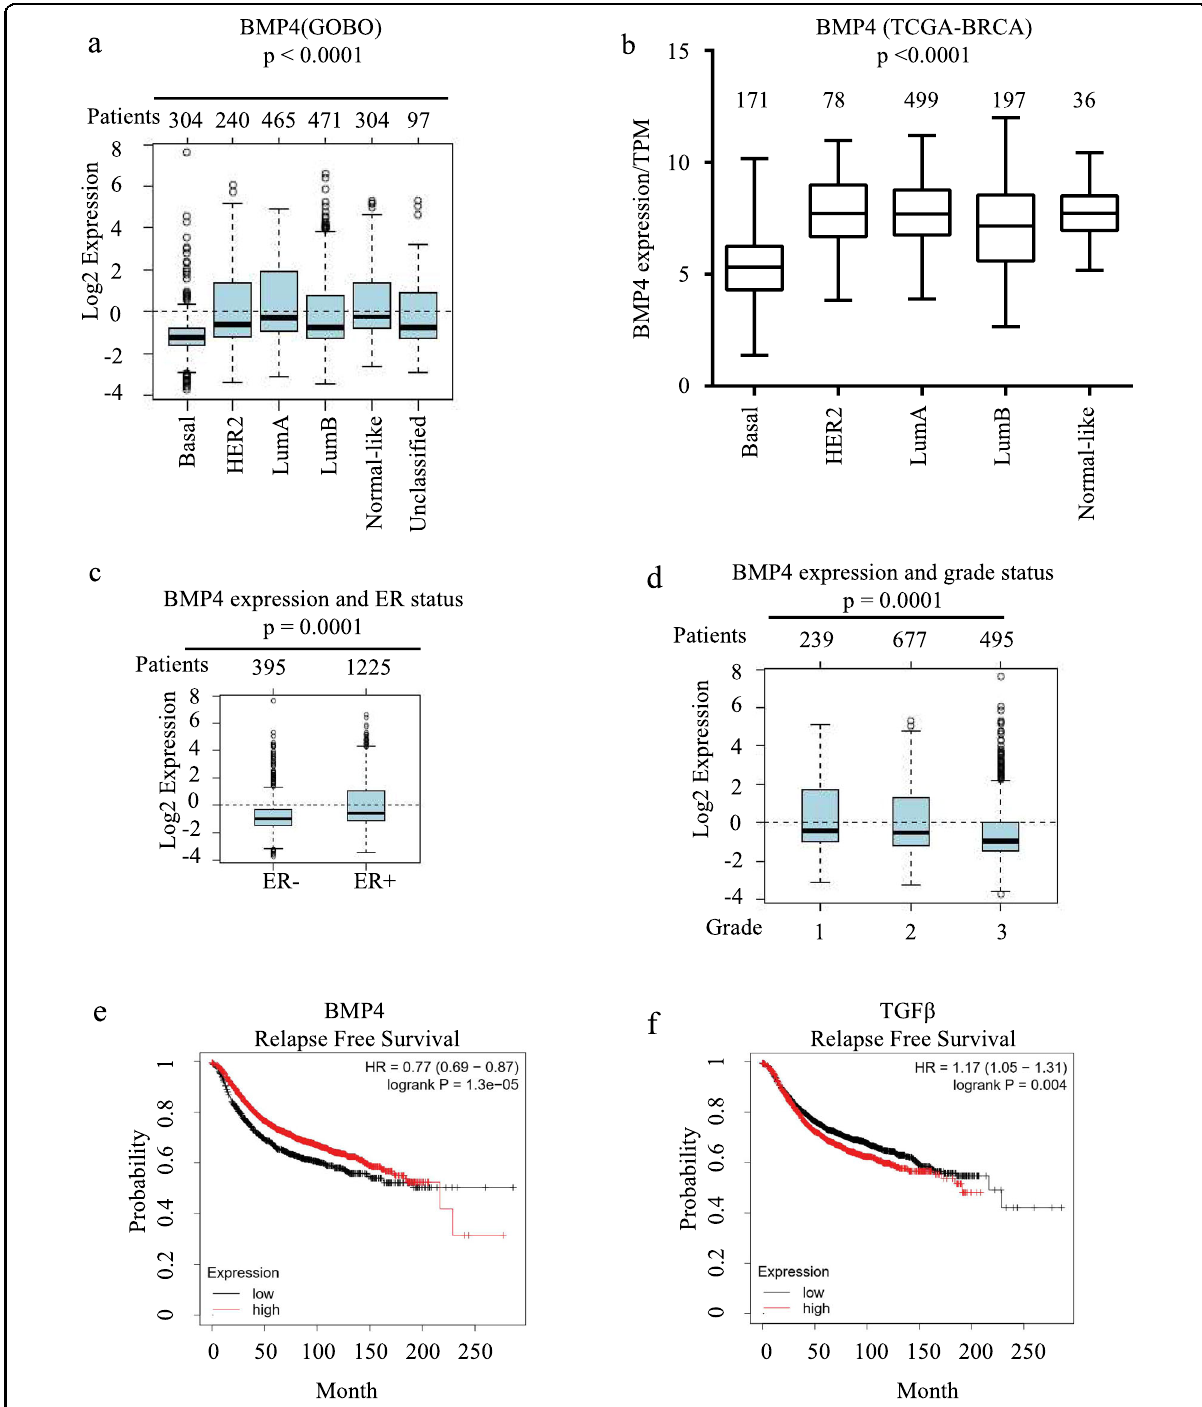
Fig. 6 BMP4 expression correlates with least aggressive breast cancer subtypes and is associated with bene fi cial clinical features. a , b Boxplot of BMP4 expression across different breast cancer subtypes using GOBO ( a ) and TCGA-BRCA ( b ) datasets. The number of patients for each subtype is indicated. c , d Boxplot of BMP4 expression in breast cancer patients classi fi ed by ER status ( c ) and tumor grades ( d ). e Kaplan – Meier survival analysis for RFS by splitting patients into low and high BMP4 expression groups. f Kaplan – Meier relapse-free survival analysis for TGF β